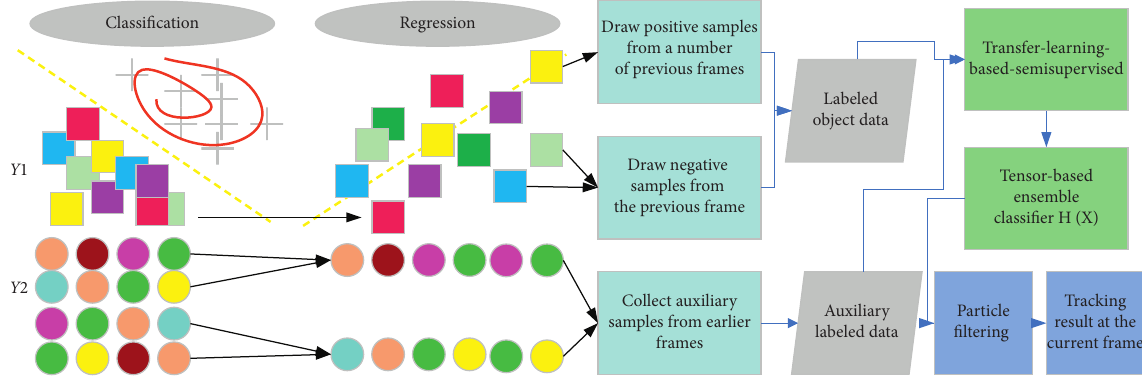
Figure 1: Diagram of the joint sparse representation model for sparse